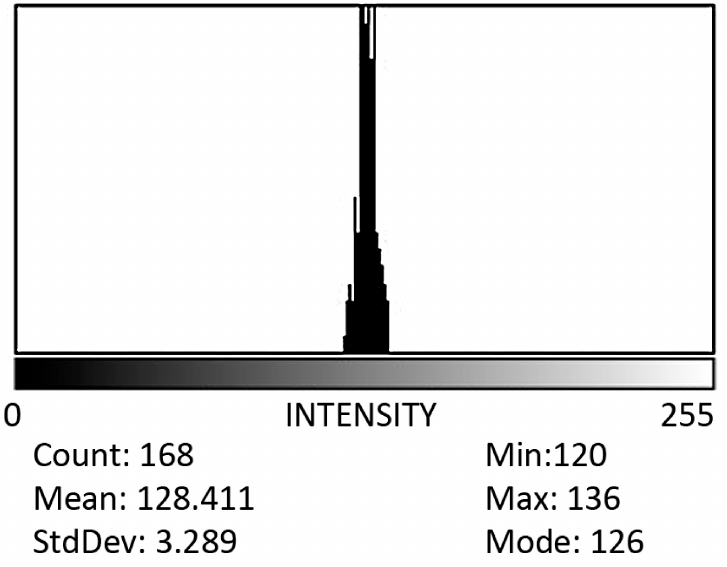
Figure 4. Sample histogram obtained from ImageJ determining the average brightness of dentin.